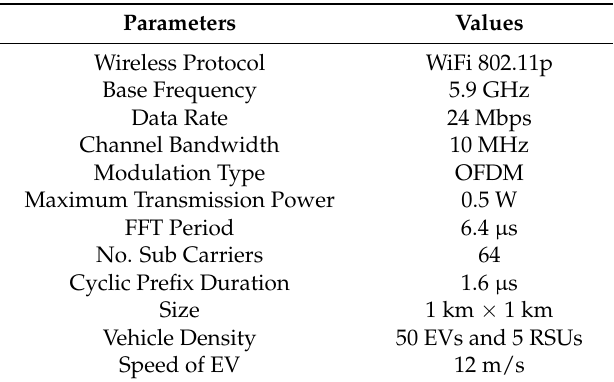
Table 4. Simulation